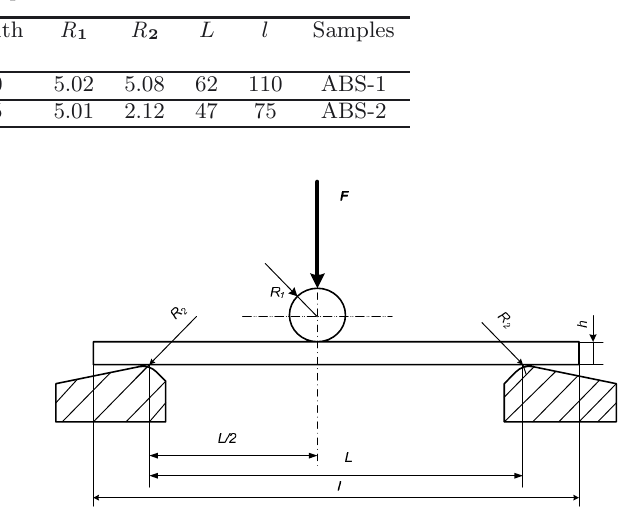
Fig. 1. Test set-up according to ISO 178